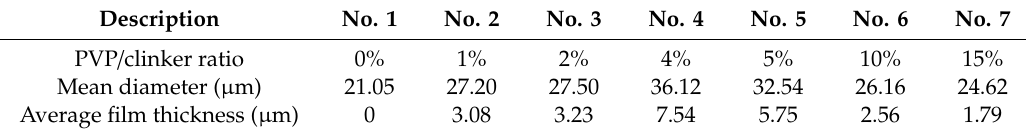
Figure 4. Particle size distribution of autolytic microspheres with di ff erent PVP / clinker ratio. Table 6. The mean diameter and average film thickness of autolytic